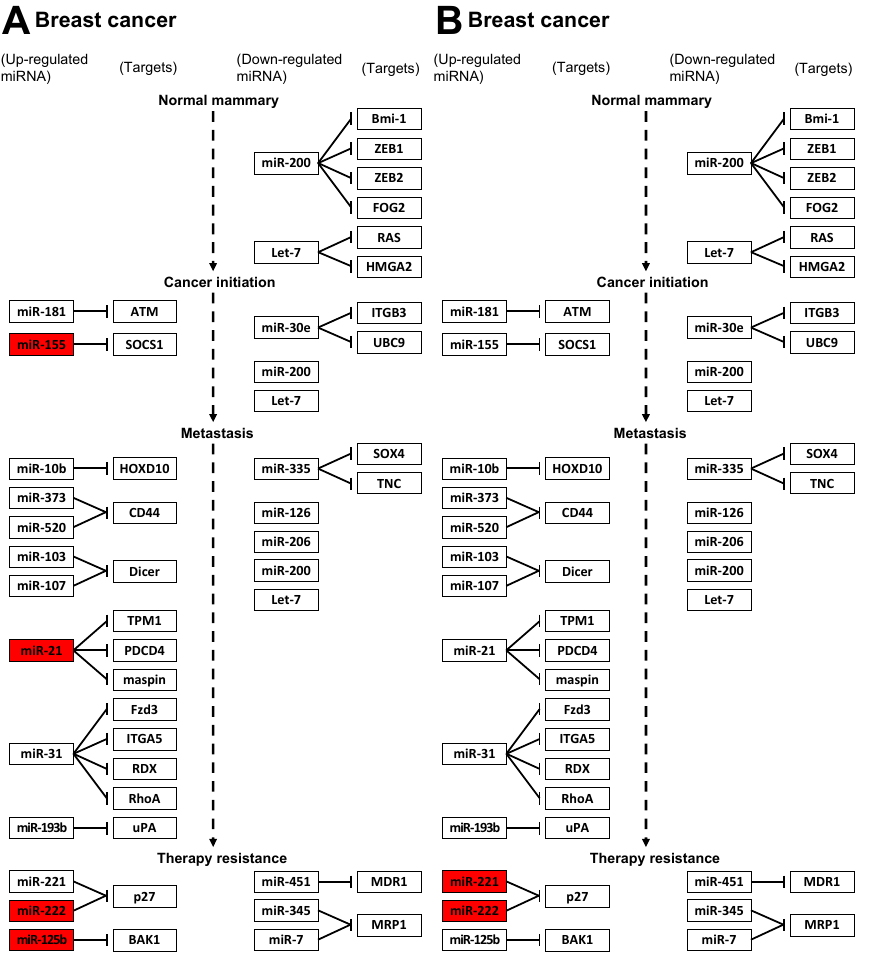
Figure 2. Pathway analysis in breast cancer. Red boxes indicate miRNAs detected in the pathway among DE-miRNAs. ( A ) BCMT-T vs. BCMT-N; ( B ) MCMT-T vs. MCMT-N. We performed gene-level analysis of DE-miRNAs based on the miRNA-gene associa- Table 1. The mRNA expression profile of miRNA-target genes. tions collected from microRNA target prediction database (miRDB). The miRDB contains BCMT-T vs. BCMT-N information regarding predicted target genes and predicted score for miRNAs. We fil- Gene Fold Change p -Value tered associations with a predictive score of >90 for miRNA-gene relationships. Since the BAK1 1.134 0.390 same gene is associated with multiple miRNAs, the collected target genes were used after CDKN1B − 1.256 0.167 de-duplication. Three hundred and seventy target genes in DE-miRNA of BCMT-T vs. PDCD4 − 2.486 <0.001 BCMT-N, six hundred and forty eight target genes in DE-miRNA of MCMT-T vs. MCMT-N, SERPINB5 0.838 and three target genes in DE-miRNA of BCMT-T vs. MCMT-T were collected. Functional − 2.183 0.005 analysis was performed using clusterProfiler based on predicted genes. Among the various TPM1 − 1.249 0.177 biological functions, we focused on specific biological functions: Autophagy, response Gene Fold Change p -Value the MCMT-T vs. BCMT-T, this comparison was excluded from the enrichment CDKN1B − 1.612 0.025